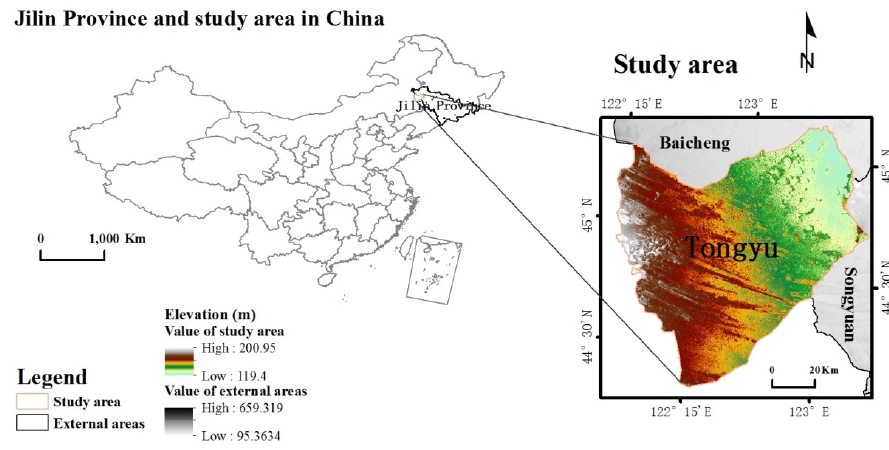
Figure 1. Location and elevation of the study area.